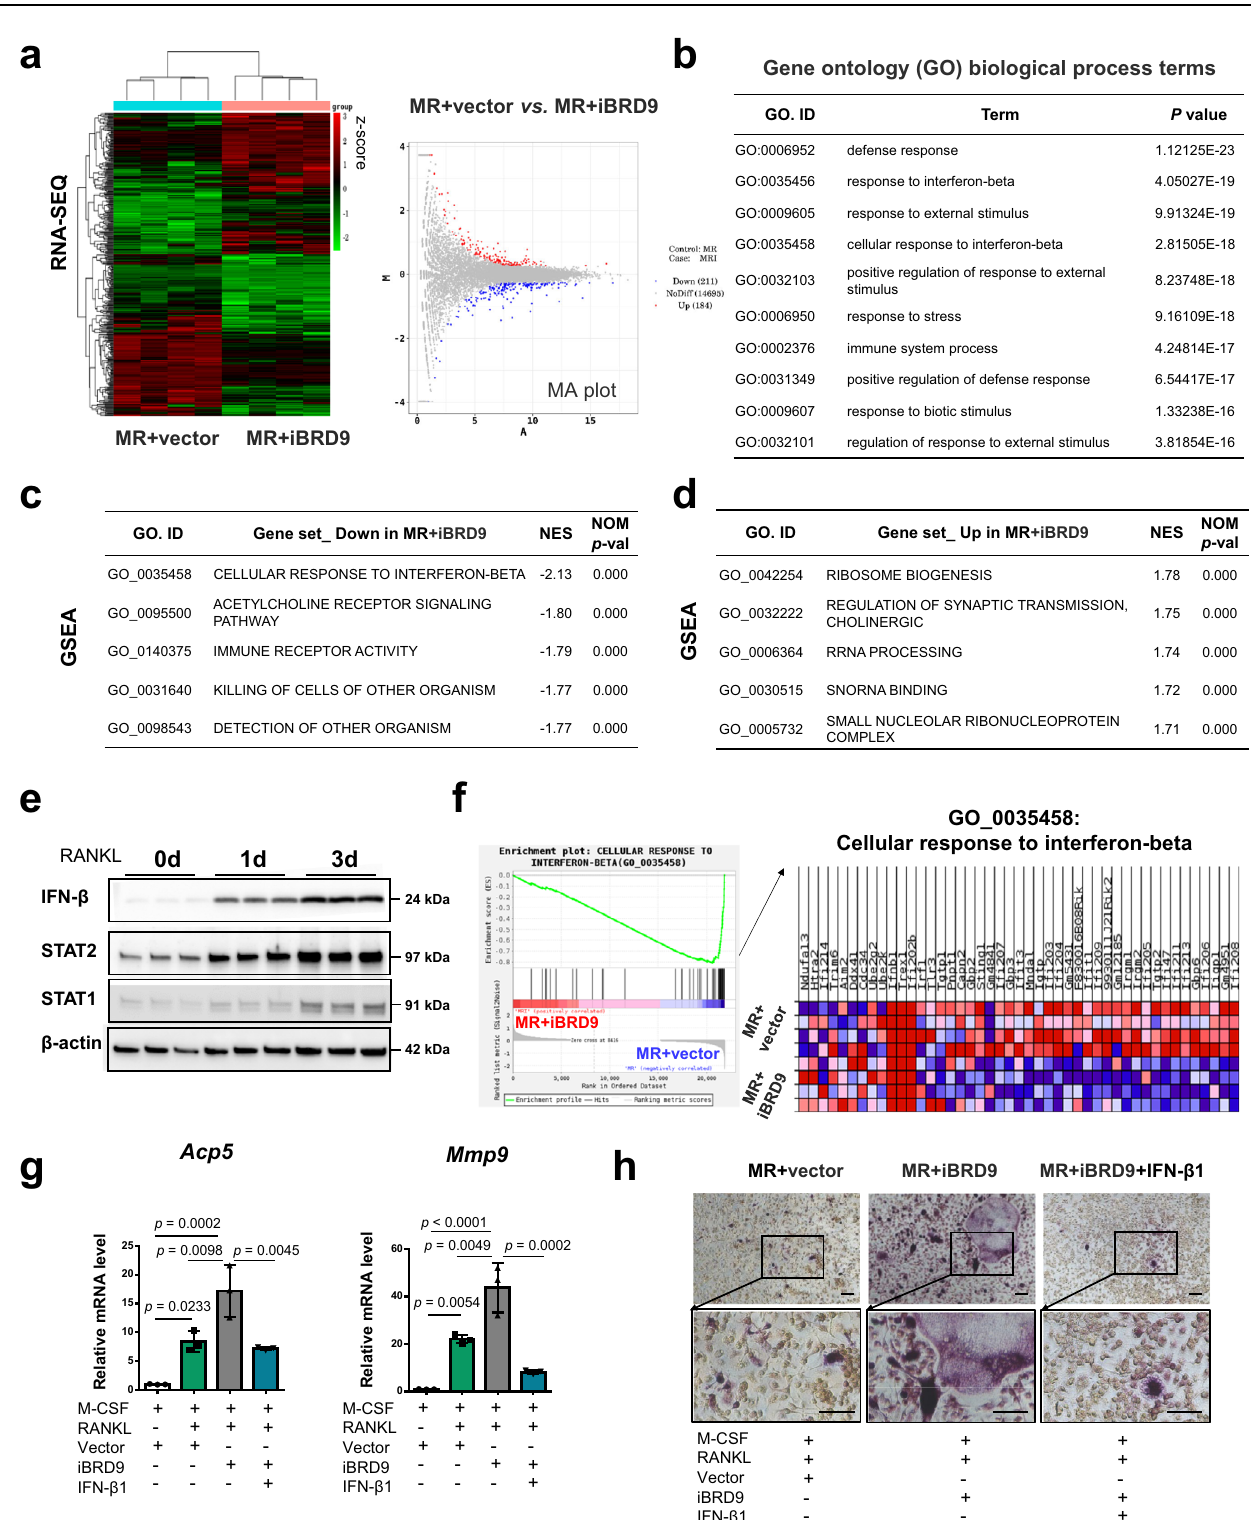
the5.5kbupstreamregulatoryregionofthemouse Stat1